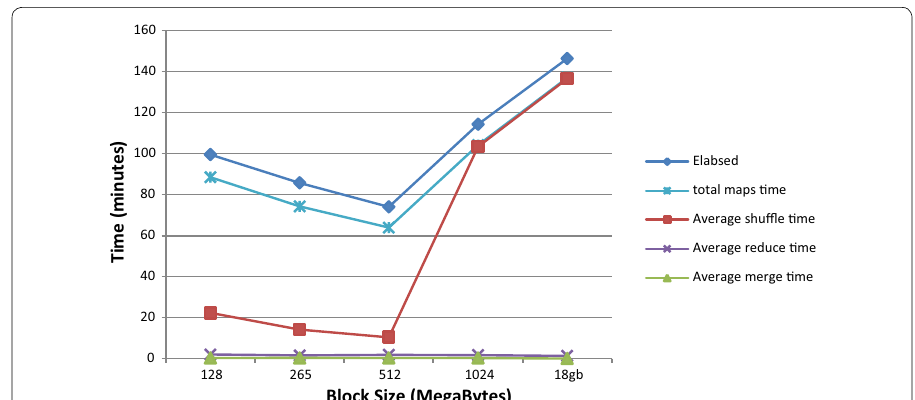
Fig. 28 Clustering 17.79 GB raster image using a 2 node Hadoop cluster